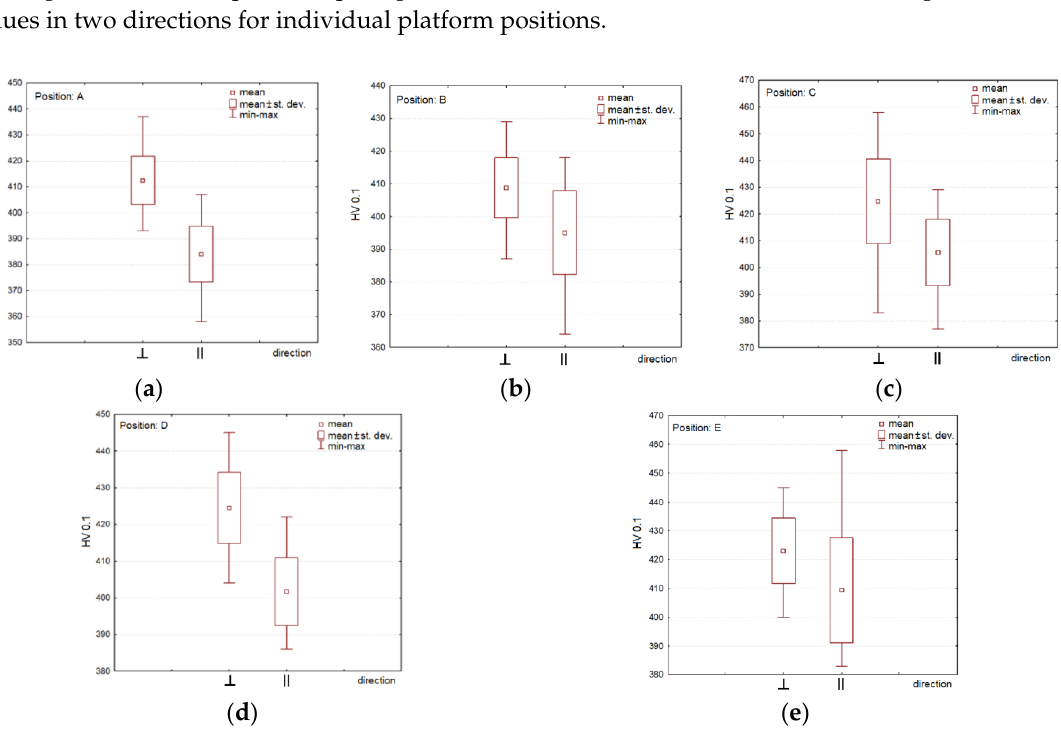
Table 5. Results of the t-test — comparison between two groups.